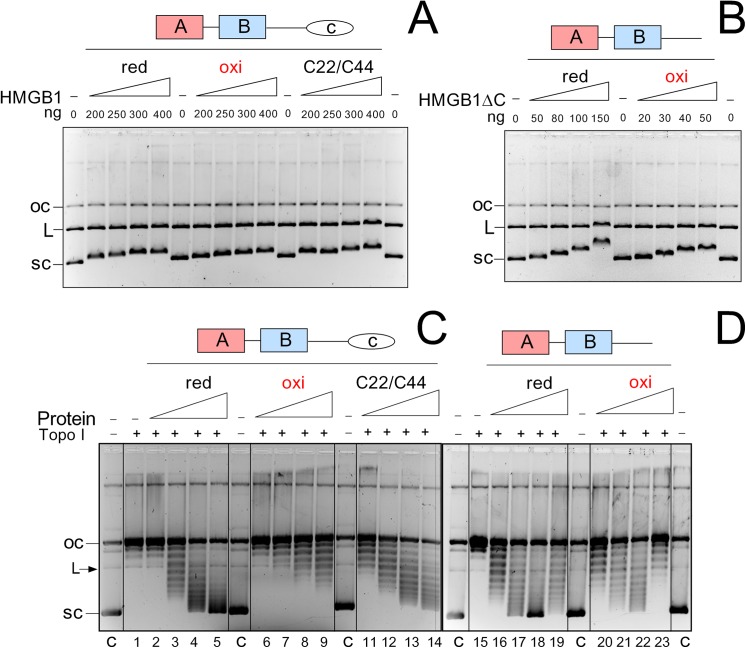
The effect of oxidization of HMGB1 on preferential binding to supercoiled DNA or DNA supercoiling.Panels A and B, preferential binding of HMGB1 or HMGB1 lacking the acidic C-tail (HMGB1ΔC) to supercoiled DNA. Proteins were pre-incubated with equimolar mixtures of supercoiled plasmid, relaxed circular plasmid and linearized plasmid pBR322, followed by resolution on 1% agarose gels. Notice that oxidization of HMGB1ΔC enhanced binding to supercoiled DNA compared to the reduced form of the protein, and therefore different amounts of reduced and oxidized HMGB1ΔC were used for the gel-retardation assay. Panels C and D, the effect of oxidization of HMGB1 on DNA supercoiling in the presence of topoisomerase I. Relaxed (circular) plasmid pBR322 DNA was incubated with increasing amount of HMGB1 or HMGB1ΔC at protein-to-DNA mass ratios of 1, 2, 4 and 6 (lanes 2–5,HMGB1-red; lanes 6–9, HMGB1-oxi; lanes 11–14, HMGB1 mutant; lanes 16–19, HMGB1ΔC-red; lanes 20–23, HMGB1ΔC-oxi) in the presence of topoisomerase I. Lanes C denote supercoiled DNA without addition of proteins. OC, relaxed, closed circular plasmid. L, linearized plasmid. SC, supercoiled plasmid. C22/C44, HMGB1(Cys22A/Cys44A) mutant. Deproteinised DNA samples were subjected to electrophoresis on 1% agarose gels, followed by staining with GelRed (Biotium).